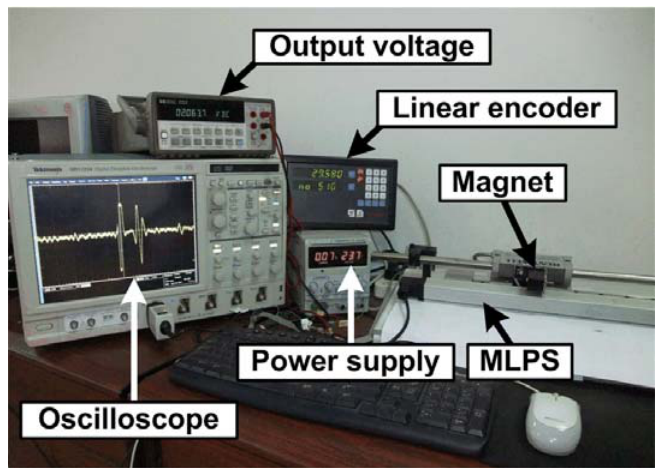
Figure 3. Experimental